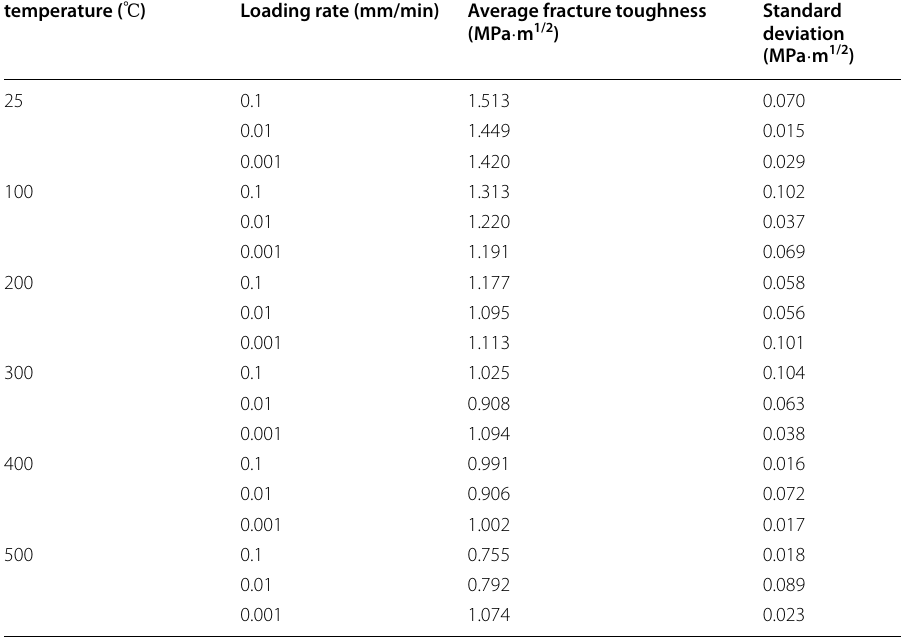
Table 1 Results of the fracture toughness temperature ( ℃ )